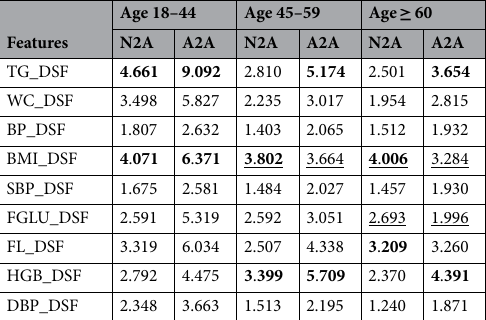
Table 5. The OR of the presistent abnormality (A2A) compared to sudden abnormal state (N2A) in male. The result with the best performance in each metric using different classifiers are marked in bold characters.